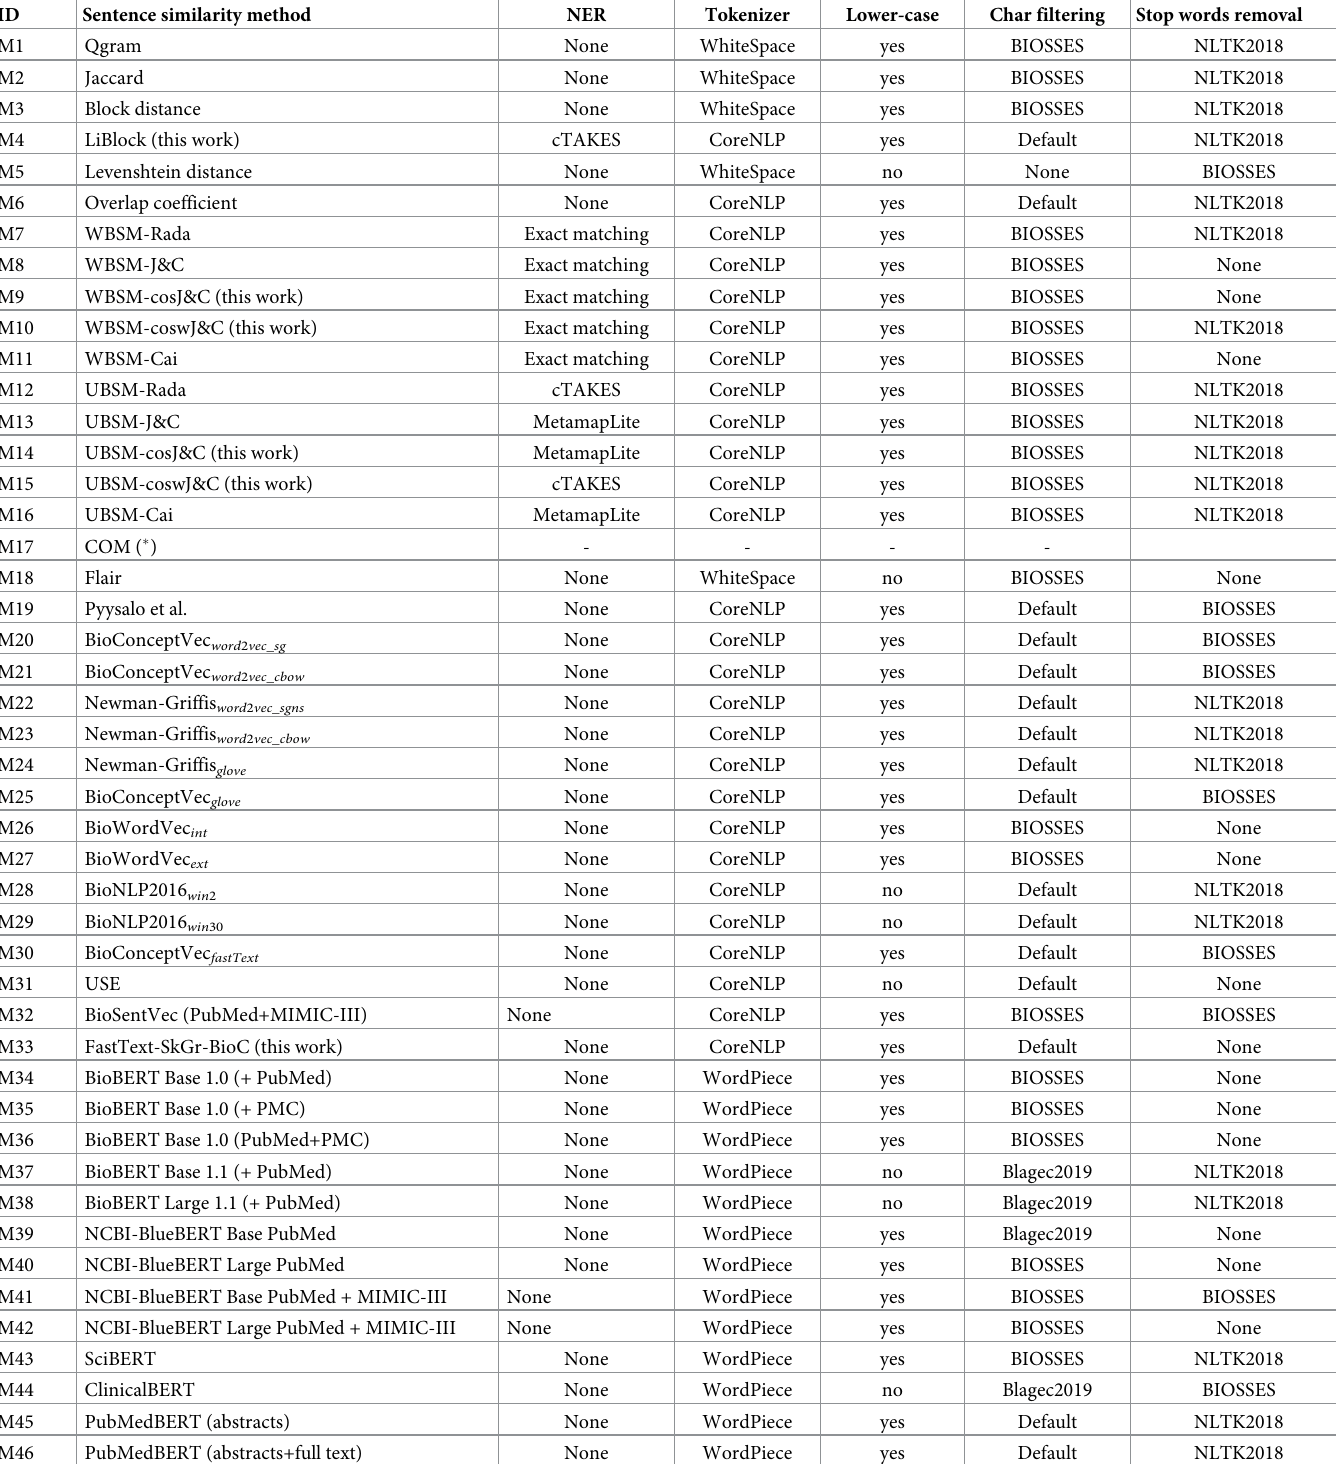
Table 7. Best-performing pre-processing configurations used to evaluate the methods compared in this work as reported in Table 8, derived from our cross-evalua- tion of each method with the pre-processing configurations shown in Fig 2 (see S2 Appendix). ( � ) COM (M17) uses the best configuration of the WBSM-Rada (M7) and UBSM-Rada (M12) methods for computing the similarity